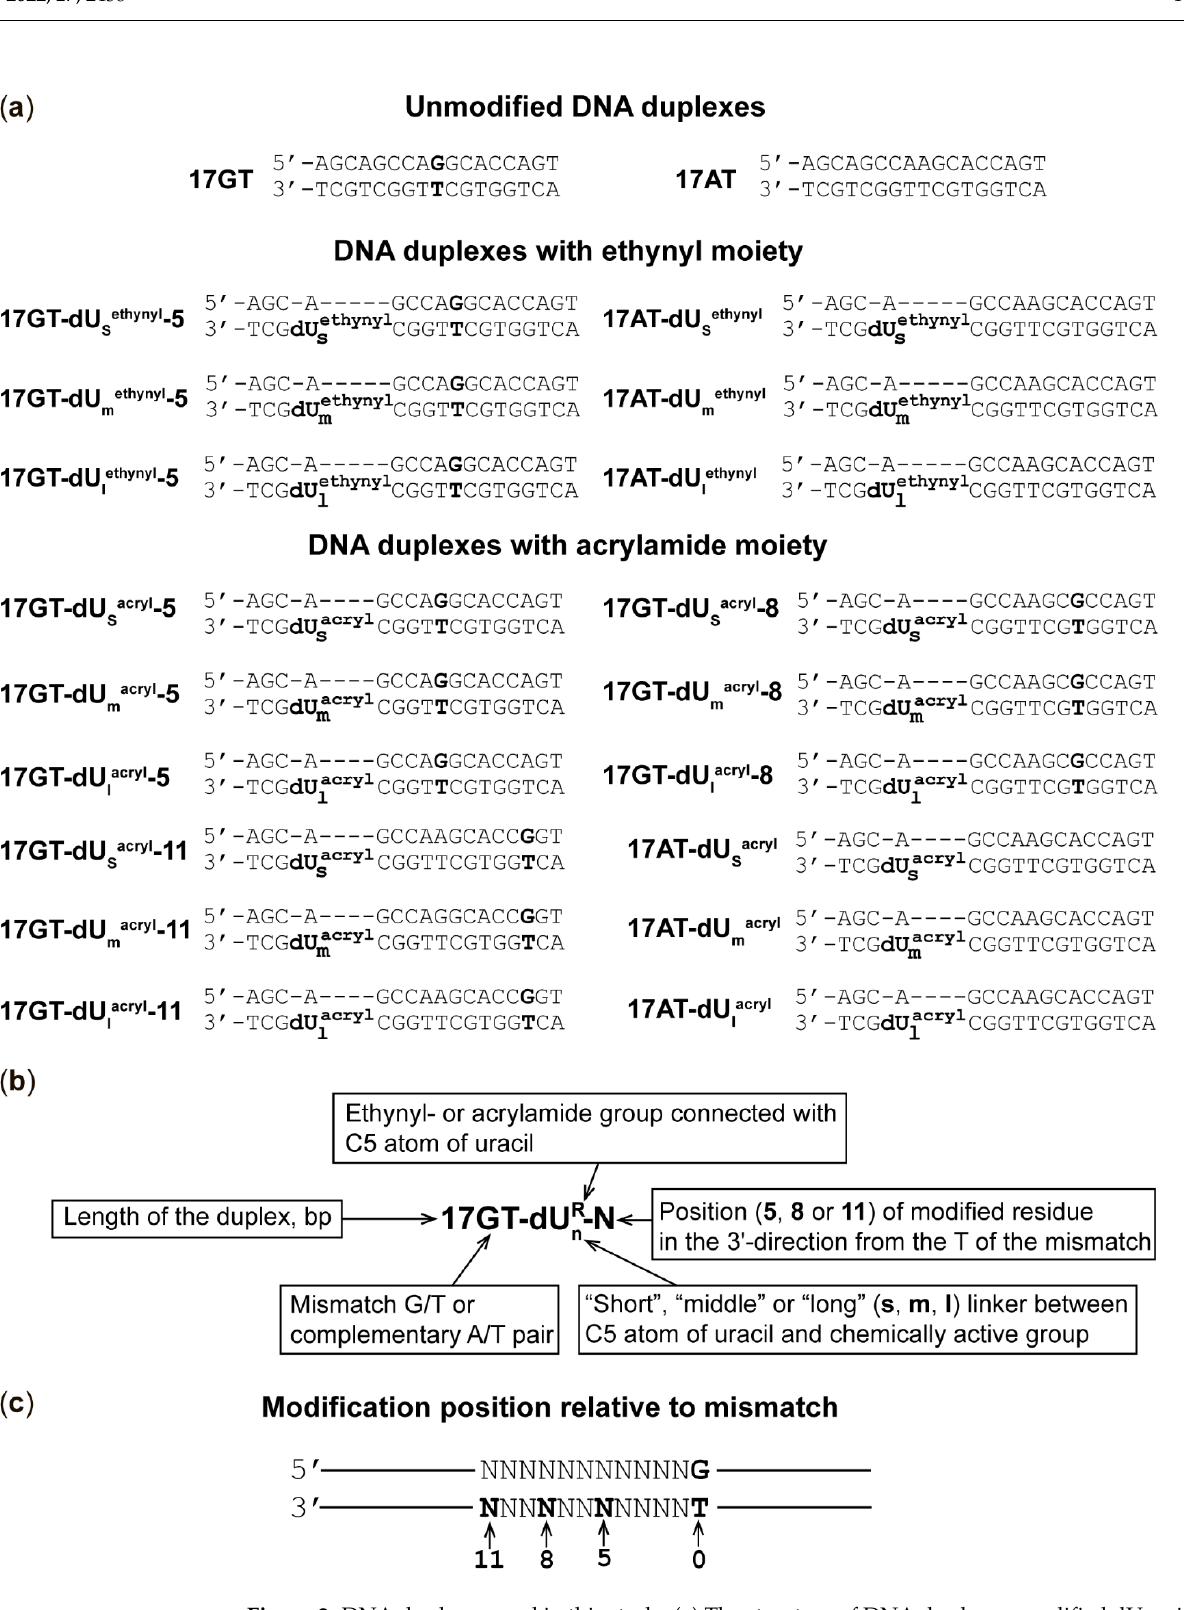
Figure 2. DNA duplexes used in this study. ( a ) The structure of DNA duplexes; modified dU residues are shown in Figure 3. ( b ) Explanation of the name of a duplex. ( c ) Illustration of positions of modified dU with respect to T of the G/T pair (position 0).